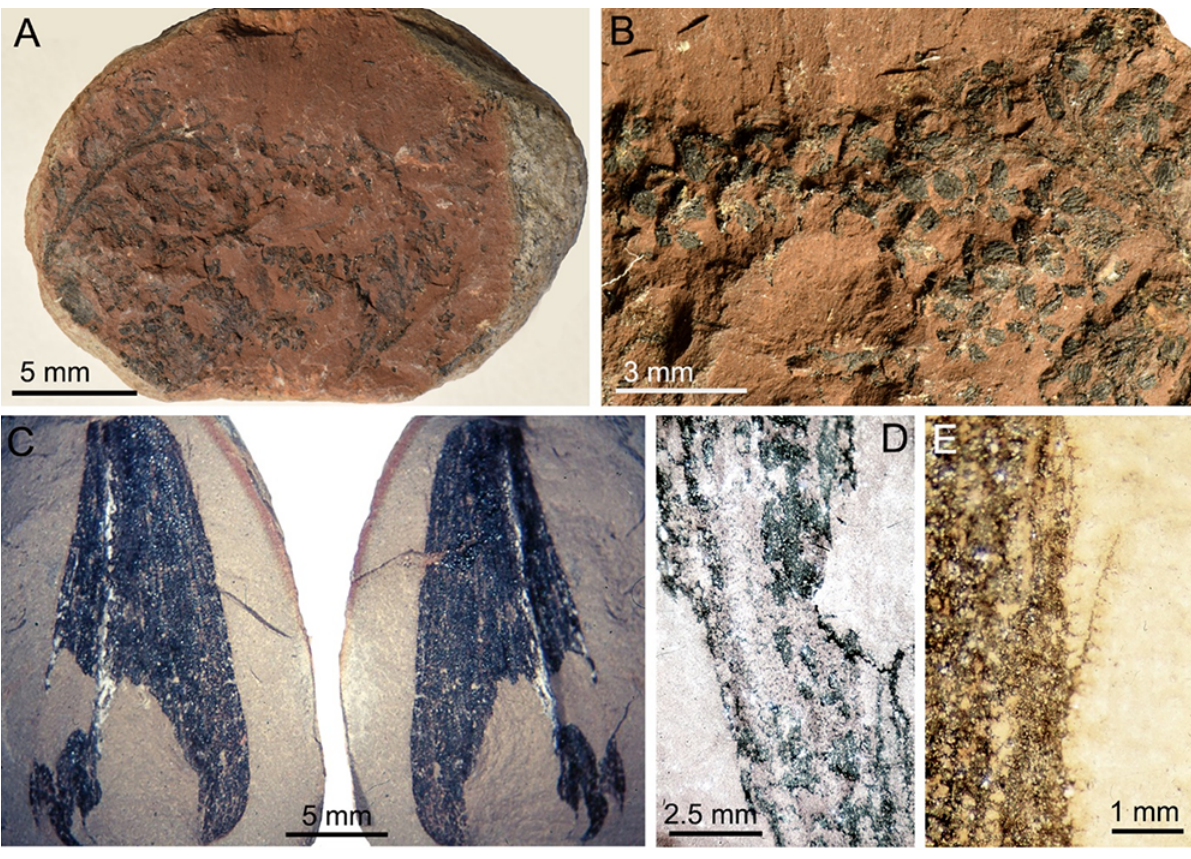
Figure 6 Seed fern pollen organs preserved within sideritic nodules from the Upper Carboniferous (Langsettian) of Sosnowiec. Lyginopteridalean pollen organ Silesiatheca formosa : ( A ) Whole pollen organ – Pinnately branching axis bearing terminal stellate synangia, S/100/P5b; ( B ) Numerous stellate synangia consisted of whorls of four–five ovate longitudinally striated microsporangia, S/100/P5a. Medullosalean pollen organ Boulayatheca ciliata : ( C ) Negative and positive of pyriform microsynangium, S/100/P4; ( D ) Enlargement of microsynangium surface, numerous hair bases visible as dark spots, S/100/P7; ( E ) Enlargement of synangium margin, needle-shaped hairs visible, they are expanded to bases, S/100/P7. All specimens stored in PC IB UJ (photos by S. Florjan and G.